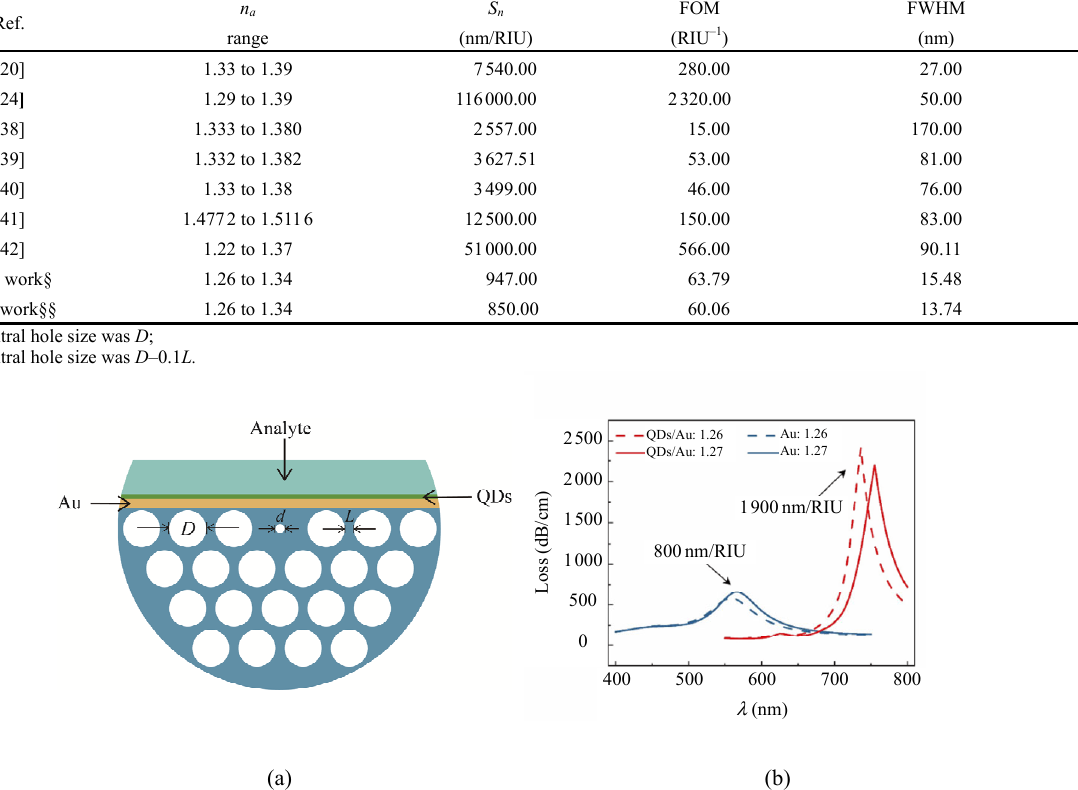
Table 4 Performance comparison with other works. Ref.